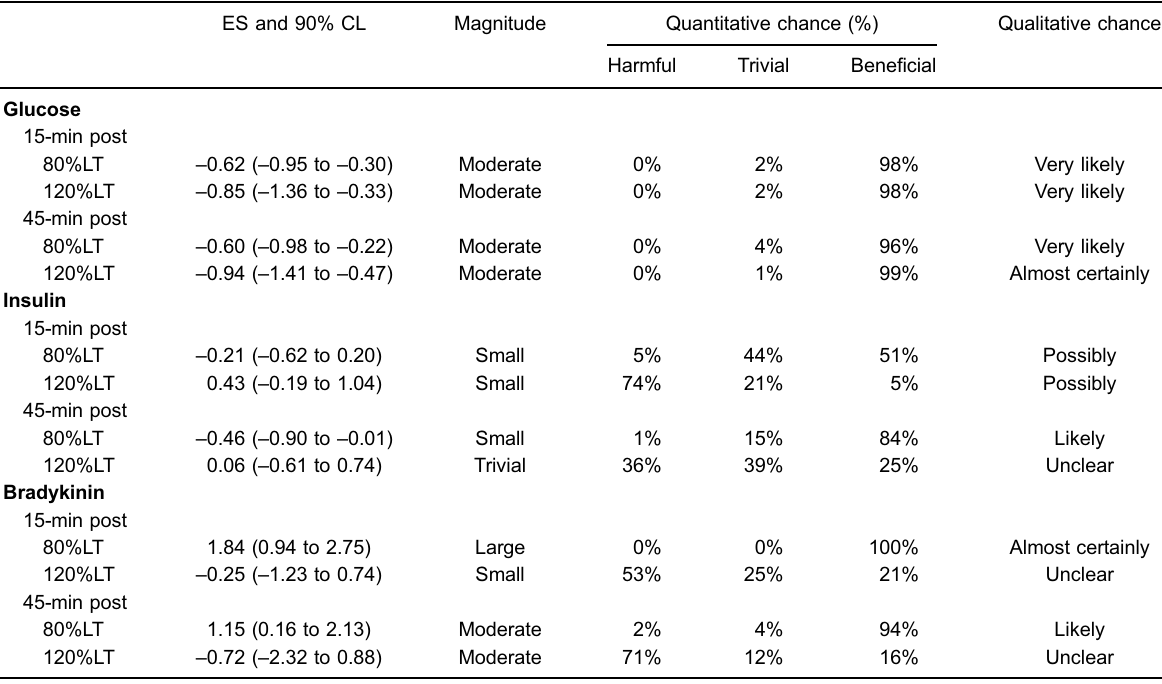
Table 2. Clinical signi fi cance following the exercise